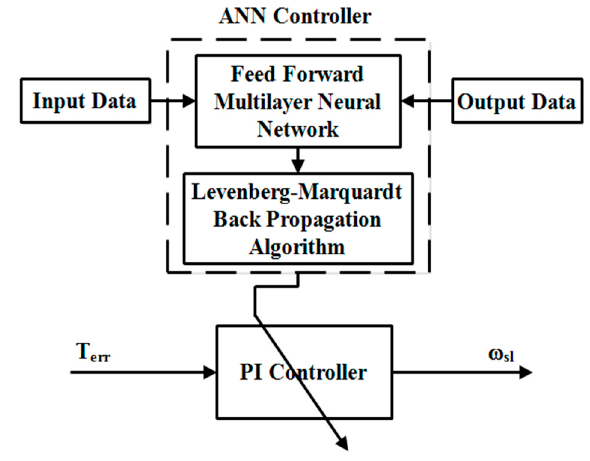
Figure 9. Basic block diagram of an ANN controller.